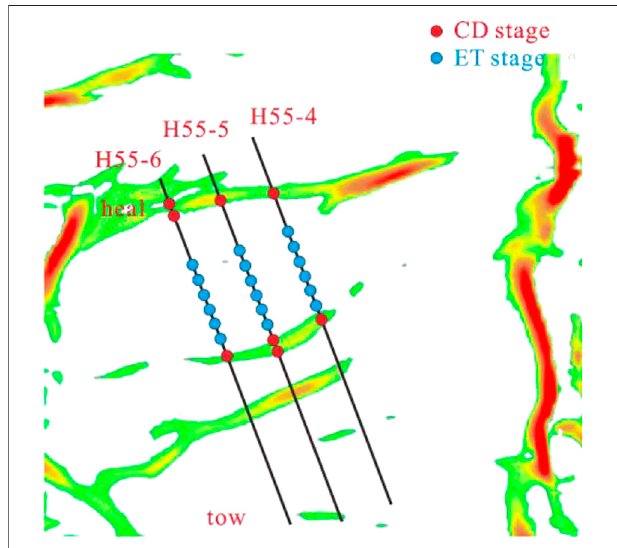
between platforms and wells. In other words, energy generated in fracturing at certain intervals may be transmitted over long distances through curvature belts different wells along the entire curvature belt may have CD of various degrees.